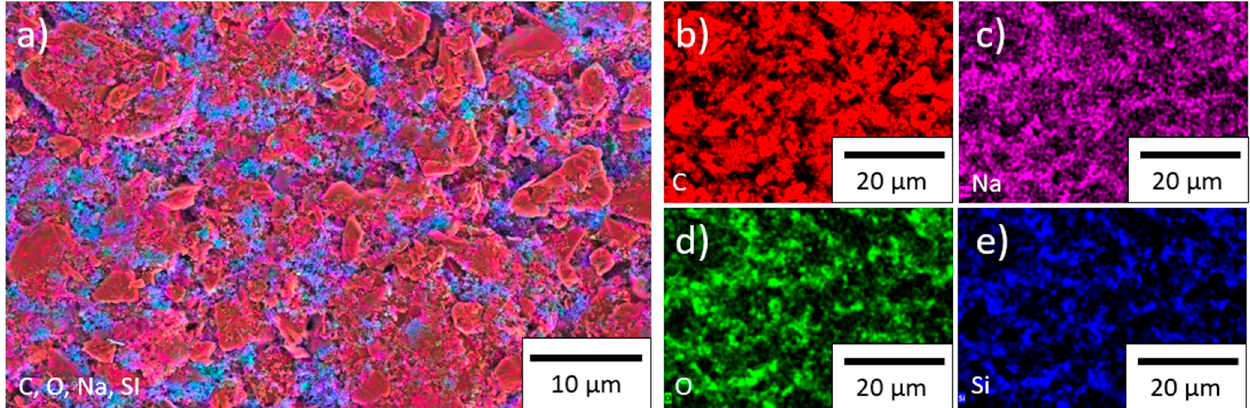
Figure 4. EDX measurements on the surface of a TSi electrode: ( a ) all detected elements, ( b ) carbon, ( c ) sodium, ( d ) oxygen, and ( e ) silicon.